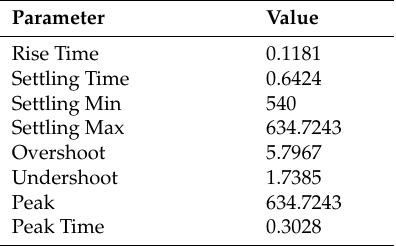
Table 8. Characteristics of the motor speed curve.